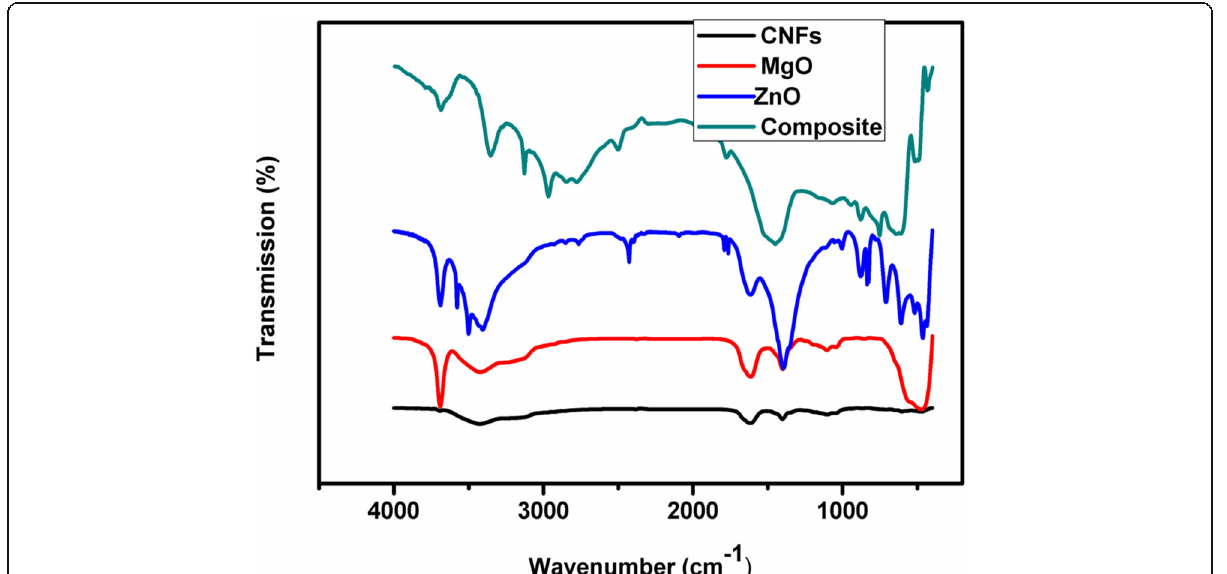
Fig. 6 FTIR spectrum of ZnO (blue), MgO (Red), MgO-ZnO@CNFs (green), and CNFs (black)